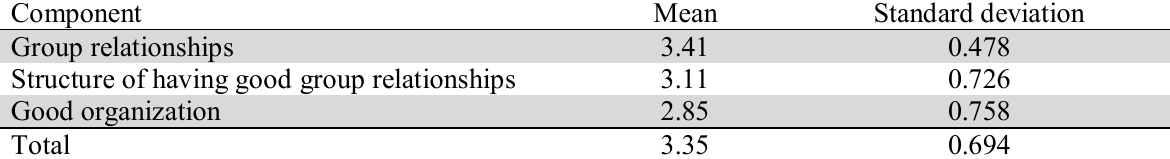
Mean and standard deviation of structural components of social capital Component Group